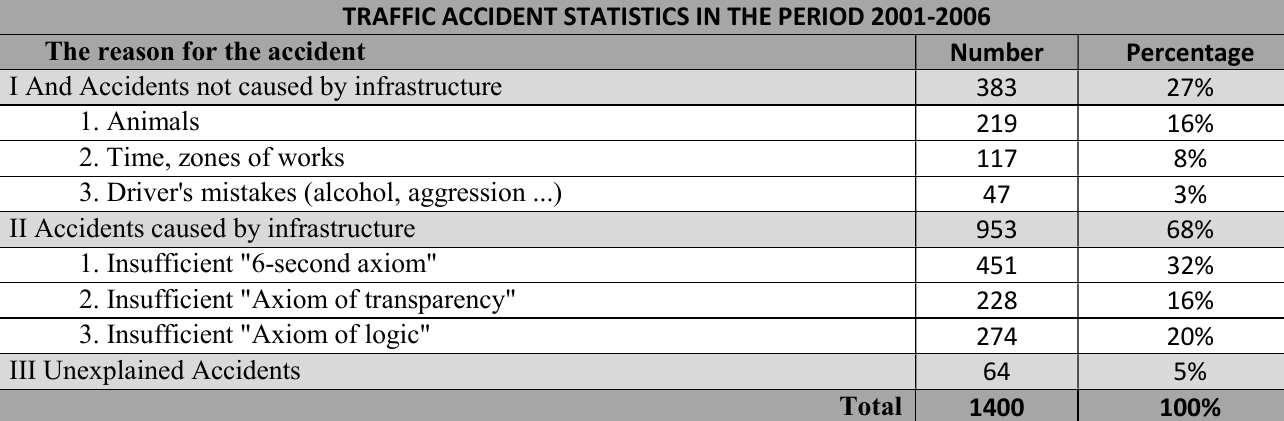
Table 2. Impact of infrastructure in the total number of traffic accidents TRAFFIC ACCIDENT STATISTICS IN THE PERIOD